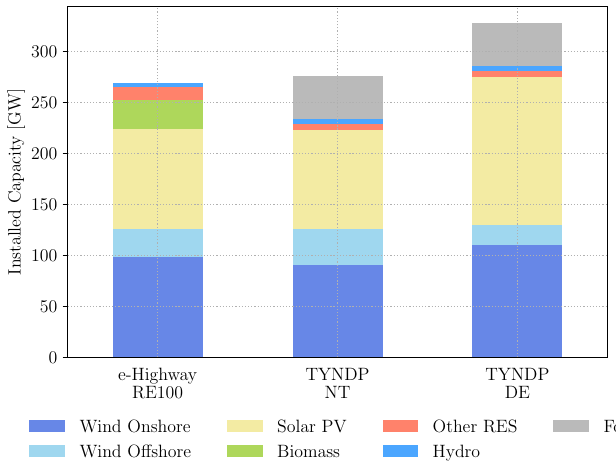
Figure 4. Overview of the installed capacities in GW per scenario and generation type with data from [24,49].